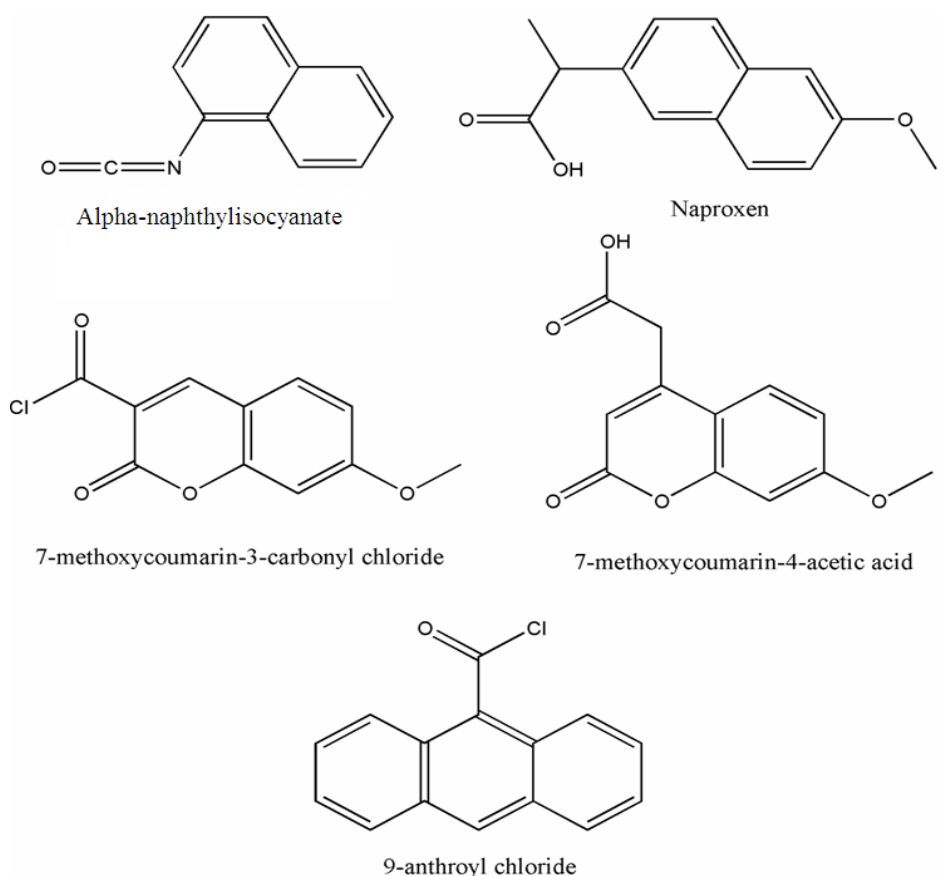
Figure 4. Chemical structures of the reagents described in Section